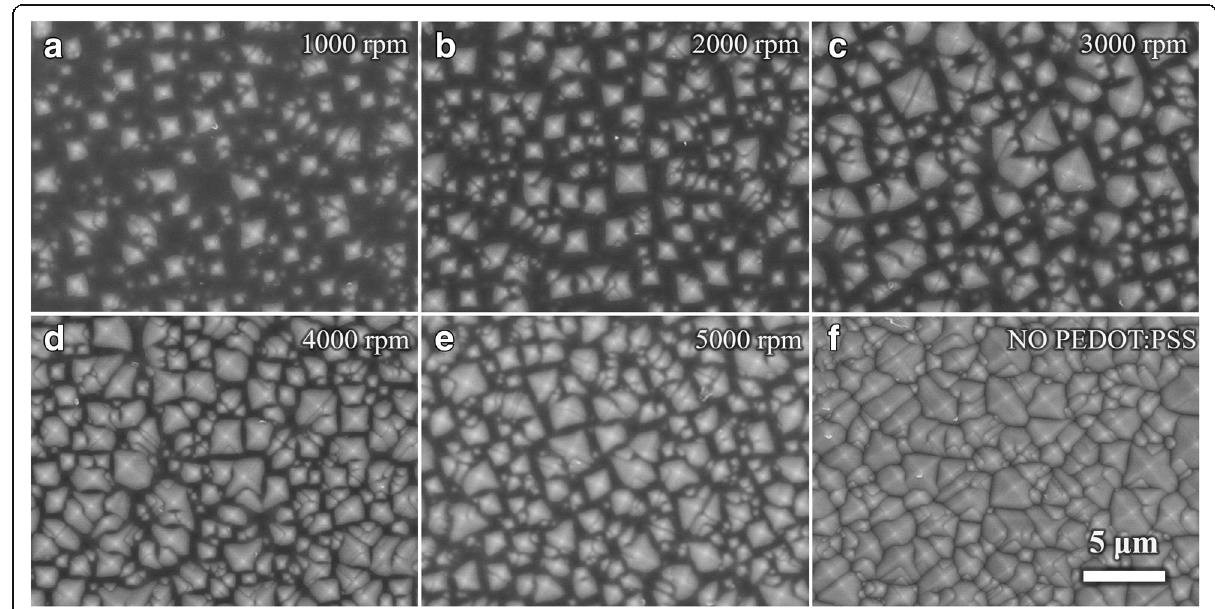
Fig. 4 The SEM top view images of textured Si with PEDOT:PSS layer. a – e coating rates range from 1000 to 5000 rpm, and f has no PEDOT:PSS layer. The scale bars in a – f are the same